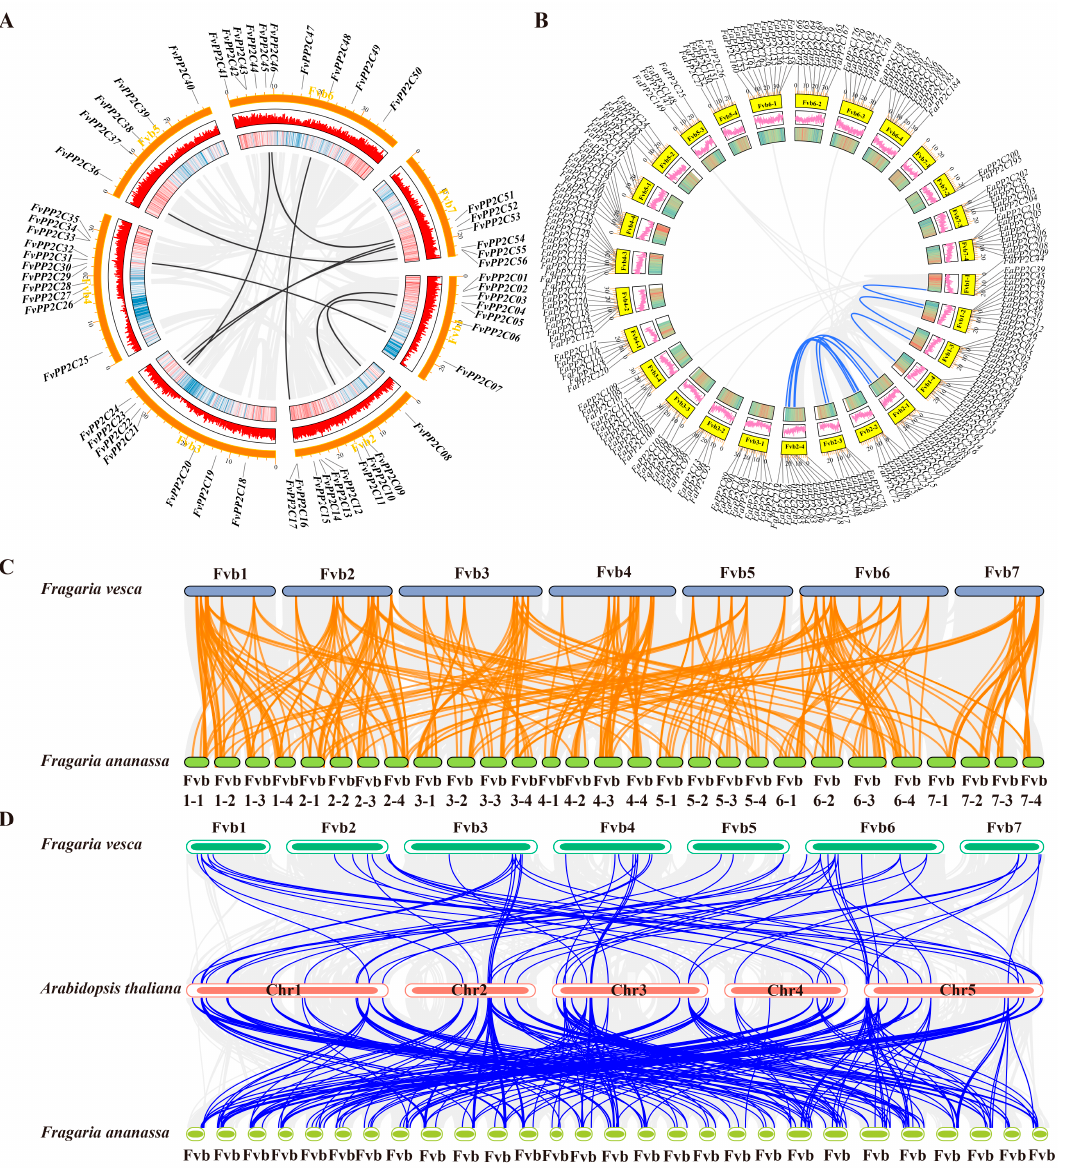
Figure 3. Collinearity analysis of the PP2C gene family. Note: ( A ) Collinearity analysis of FvPP2Cs . The orange bars represent chromosomes. The gray lines represent all collinear genes in the woodland strawberry, and black lines represent the FvPP2C collinearity genes. ( B ) Collinearity analysis of FaPP2Cs . The yellow bars represent chromosomes. The gray lines represent all collinear genes in the pineapple strawberry, and blue lines represent the FaPP2C collinearity genes. ( C ) Collinearity analysis of the PP2C genes between woodland strawberry and pineapple strawberry. The gray lines denote collinearity between all genes and the orange lines denote collinearity between the two PP2C family members. ( D ) Collinearity analysis of the PP2C genes in strawberry to A. thaliana . The gray lines represent collinearity between all genes, and the blue lines represent collinearity of the PP2C